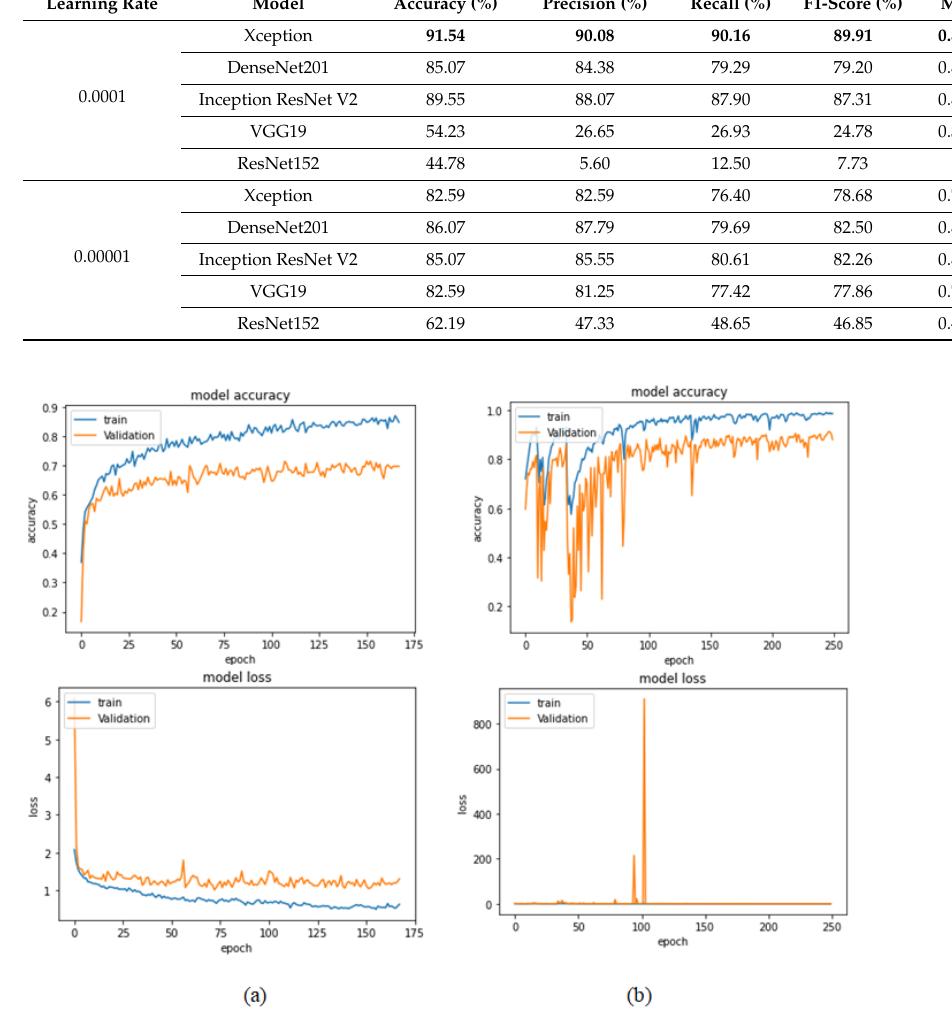
Figure 27. Learning curves for Xception at 0.0001 learning rate in 200 × magnification-dependent multi-classification. ( a ) Accuracy and loss curves of Phase 1 of training. ( b ) Accuracy and loss curves of Phase 2 of training.